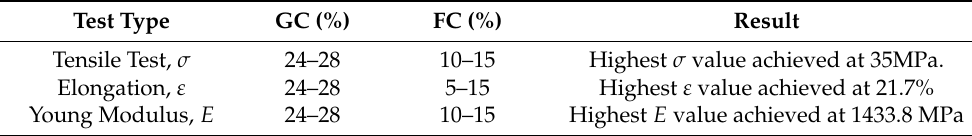
Figure 5. Effect of acetylated sugarcane fibre content (FC) and glycerol content (GC) on: ( A ) tensile strength (σ), ( B ) elongation (ε), and ( C ) young modulus of acetylated starch-based bio-composites reinforced with acetylated sugarcane fibre [46]. Table 3. Mechanical test result